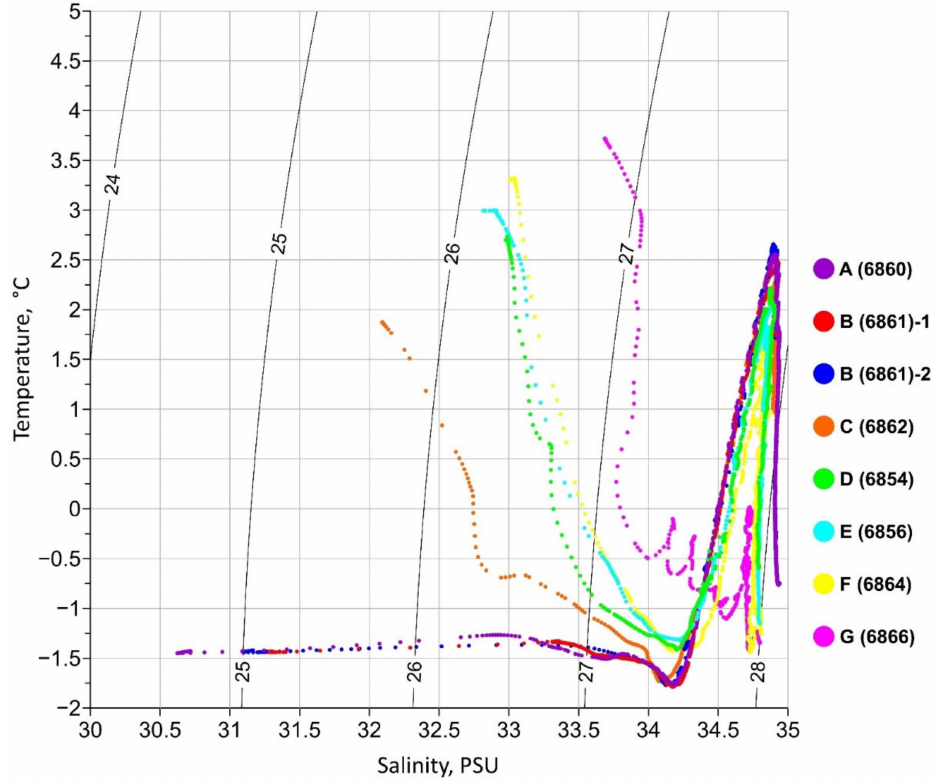
Figure 3. Temperature–salinity plots of all stations in August